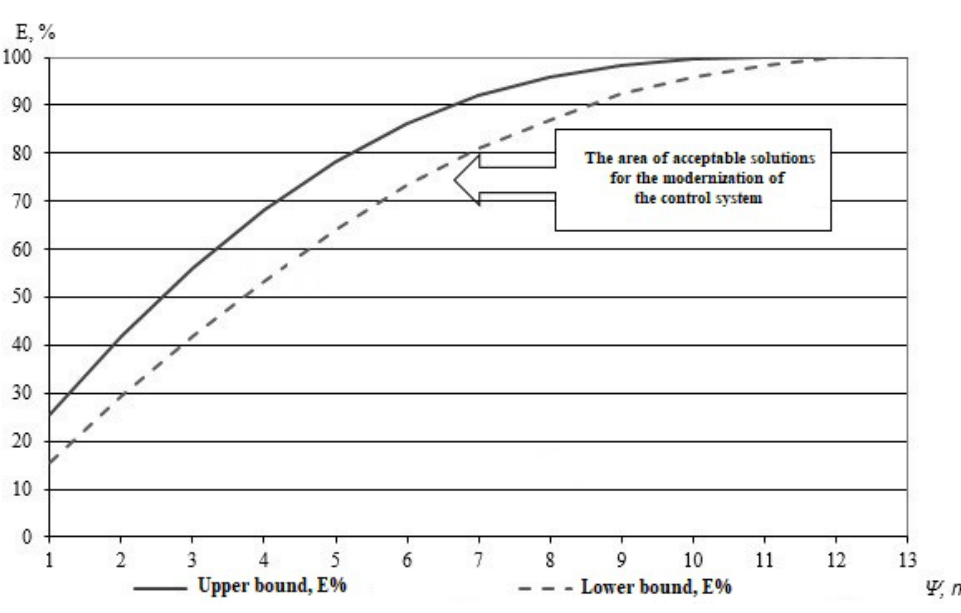
Figure 3. The area of acceptable solutions for the modernization of the control